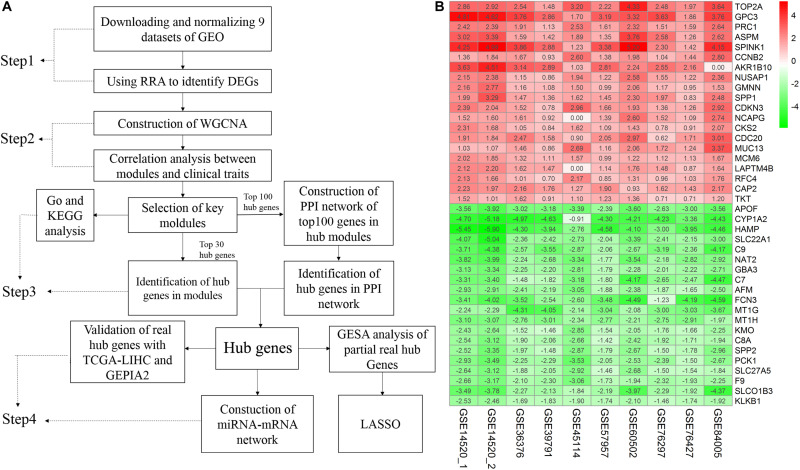
Study workflow and heatmap of the top 20 robust DEGs. (A) Study workflow. GEO, Gene Expression Omnibus; RRA, Robust Rank Aggregation; DEGs, differentially expressed genes; WGCNA, weighted gene co-expression network analysis; KEGG, Kyoto Encyclopedia of Genes and Genomes; GO, Gene Ontology; PPI, protein– protein interaction. GSEA, Gene Set Enrichment Analysis. GEPIA2, gene expression profiling interactive analysis. LASSO, least absolute shrinkage and selection operator (B) Robust DEGs analyzed by RRA. The top 20 up and down regulated genes according to the fold change value of the RRA analysis are shown in this heatmap. The row names are DEGs. The column names are GEO datasets. The numbers in each cell represent logarithmic fold change in each dataset calculated by the “limma” R package. “0” indicates that the gene corresponding to the row is missing in the data set corresponding to the column. Red indicates that DEGs are upregulated in HCC samples, while green indicates the opposite. DEGs, differentially expressed genes; GEO: Gene Expression Omnibus; RRA: robust rank aggregation. GSE14520_1, dataset from GPL571, GSE14520_2, dataset from GPL3921.